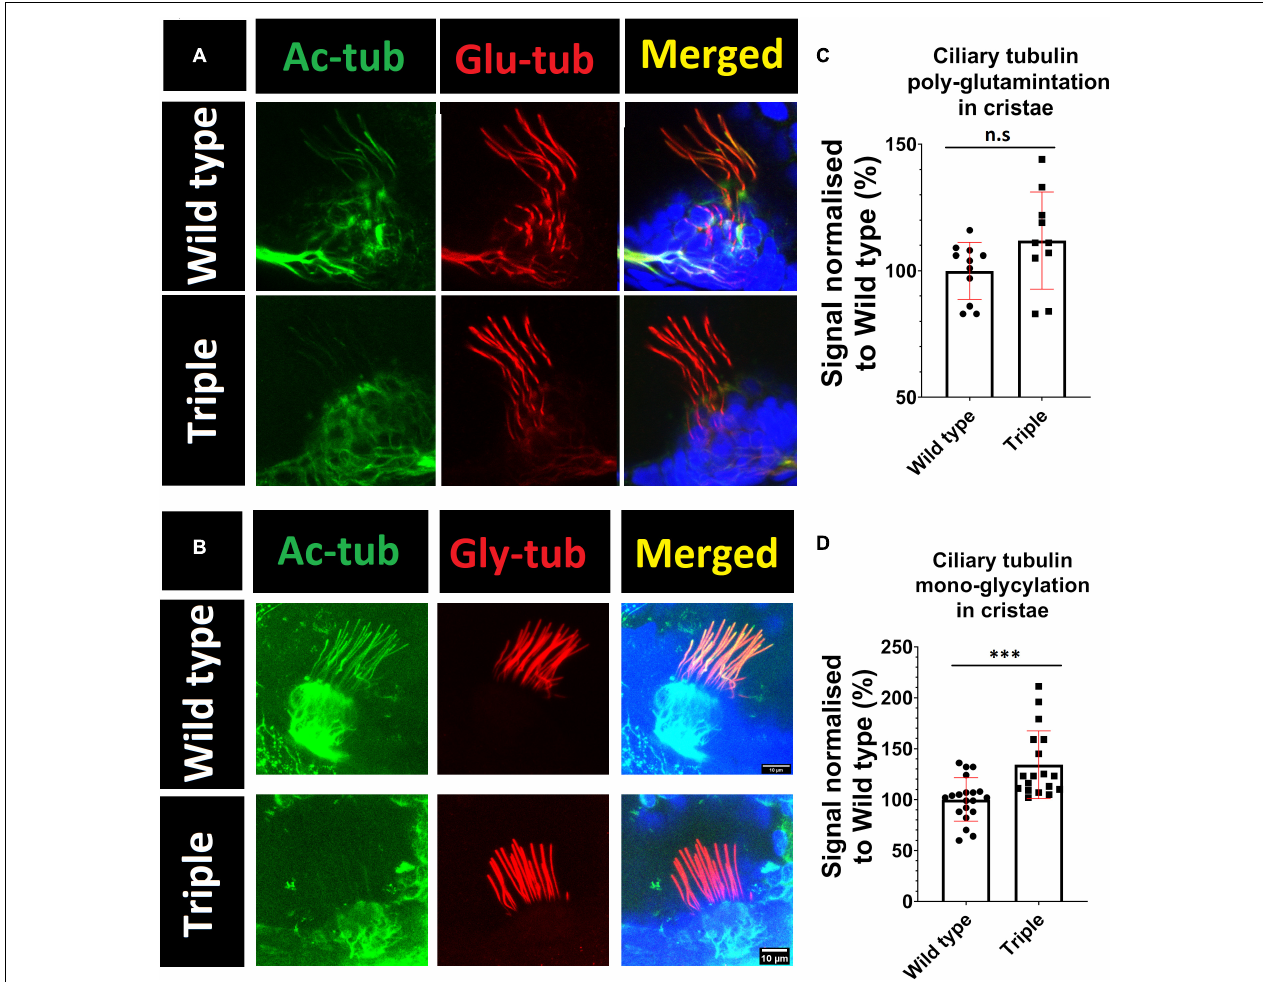
FIGURE 5 | Increase in mono-glycylation, but not poly-glutamination, of tubulin in triple mutant cilia. Green acetylated tubulin, red (A) poly-glutamylated tubulin (B) mono-glycylated tubulin Blue DAPI. (C,D) signals normalized to wild type. t -test *** p < 0.05. ns, no